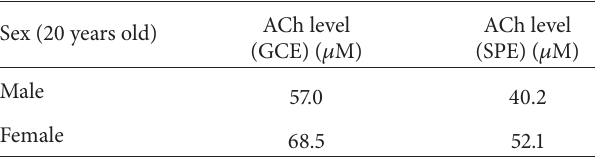
Table 1: Results of the ACh level in human blood sample using AChE-ChOx-modified biosensor based on GCE and SPE a